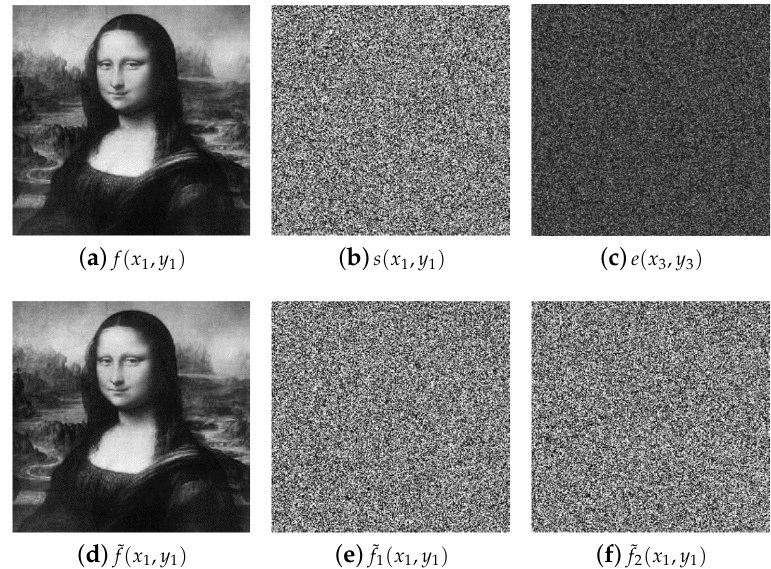
Figure 3. ( a ) Original image f ( x 1 , y 1 ) . ( b ) Random code image s ( x 1 , y 1 ) of the RPM r ( x 1 , y 1 ) . ( c ) Encrypted image e ( x 3 , y 3 ) for the security key d 1 = 200 mm, d 2 = 300 mm, θ y = 14.5 ◦ , ϕ y = 12.7